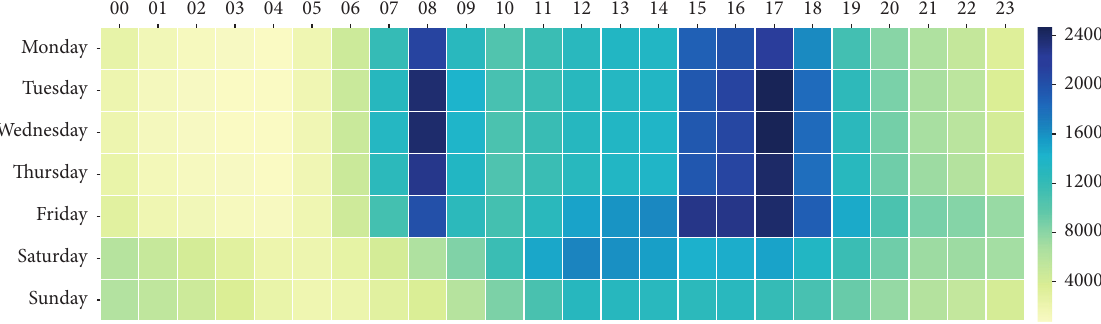
Figure 4: Traffic accident distribution per day and hour.